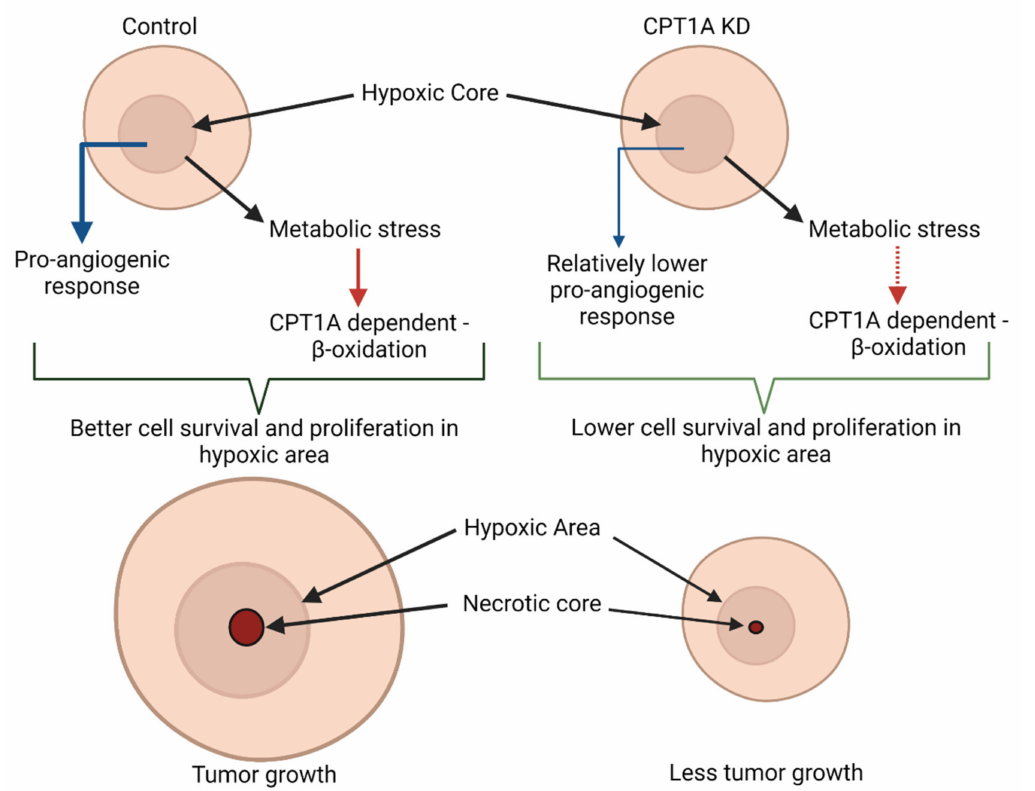
Figure 8. Role of CPT1A expression in regulating PCa cell survival and proliferation in the hypoxic microenvironment. Rapid tumor growth results in a hypoxic microenvironment causing a multitude of genetic and epigenetic changes, effectively altering the dynamics of the tumor microenvironment. In our study, cells with CPT1A overexpression showed enhanced proliferation, stemness, and tumor growth compared to controls under conditions of hypoxia, mildly affecting angiogenic response. The observed proliferative advantage was effectively abrogated with stable CPT1A knockdown.